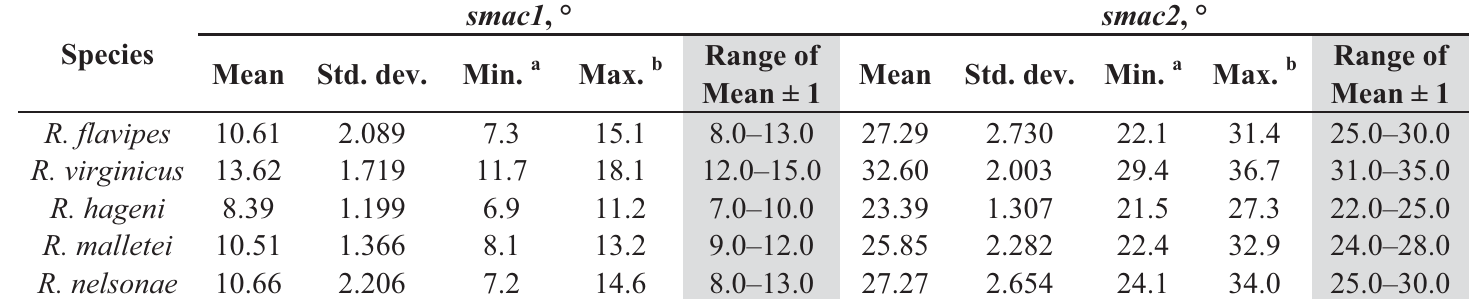
Note: Shaded boxes represent values that were used in building the dichotomous key for soldiers and